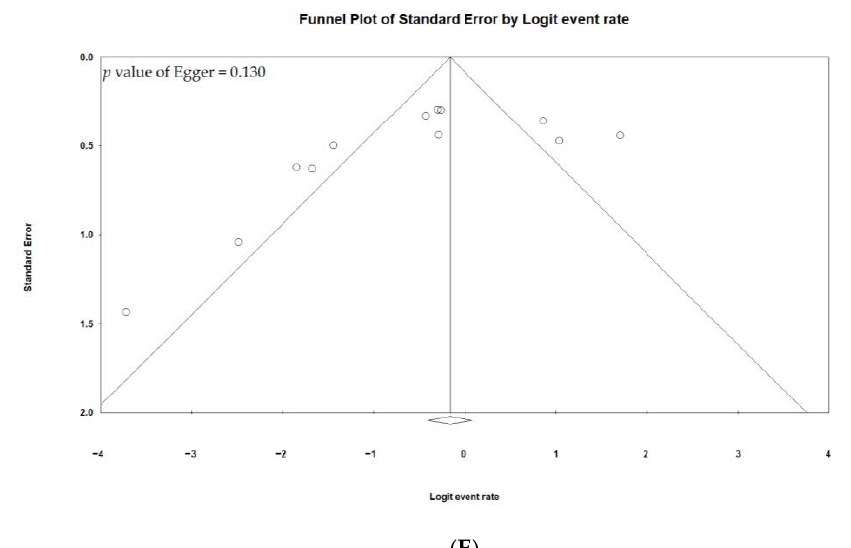
Figure 4. Funnel plots for Objective response ( A ), Clinical benefit ( B ), 3-year local control rate ( C ), 3-year overall survival ( D ), and grade 3/4 adverse events ( E ).